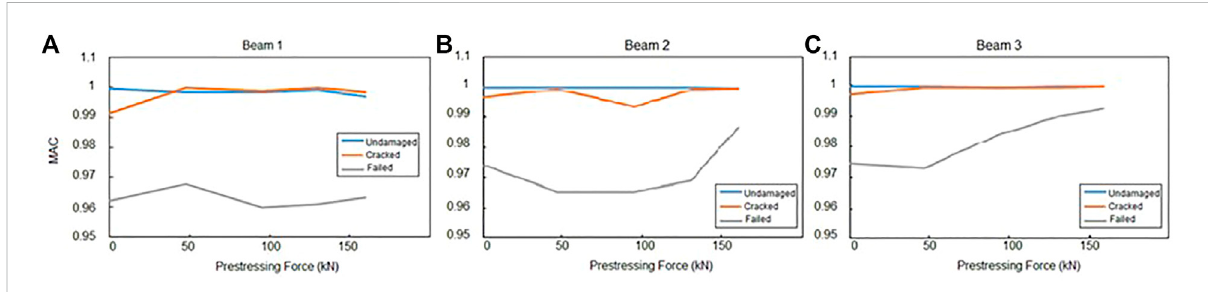
FIGURE 5 MAC index as a function of the applied fl exural load (undamaged - cracked - failed) and prestressing force for the fi rst vertical modal